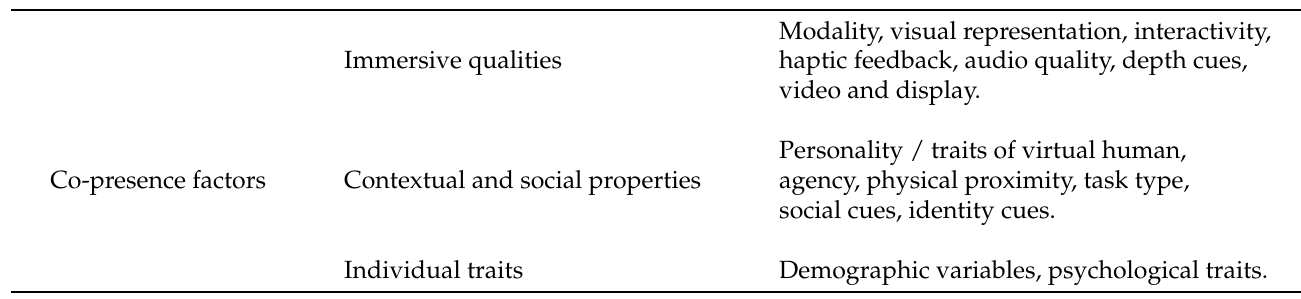
Table 2. Categorization of